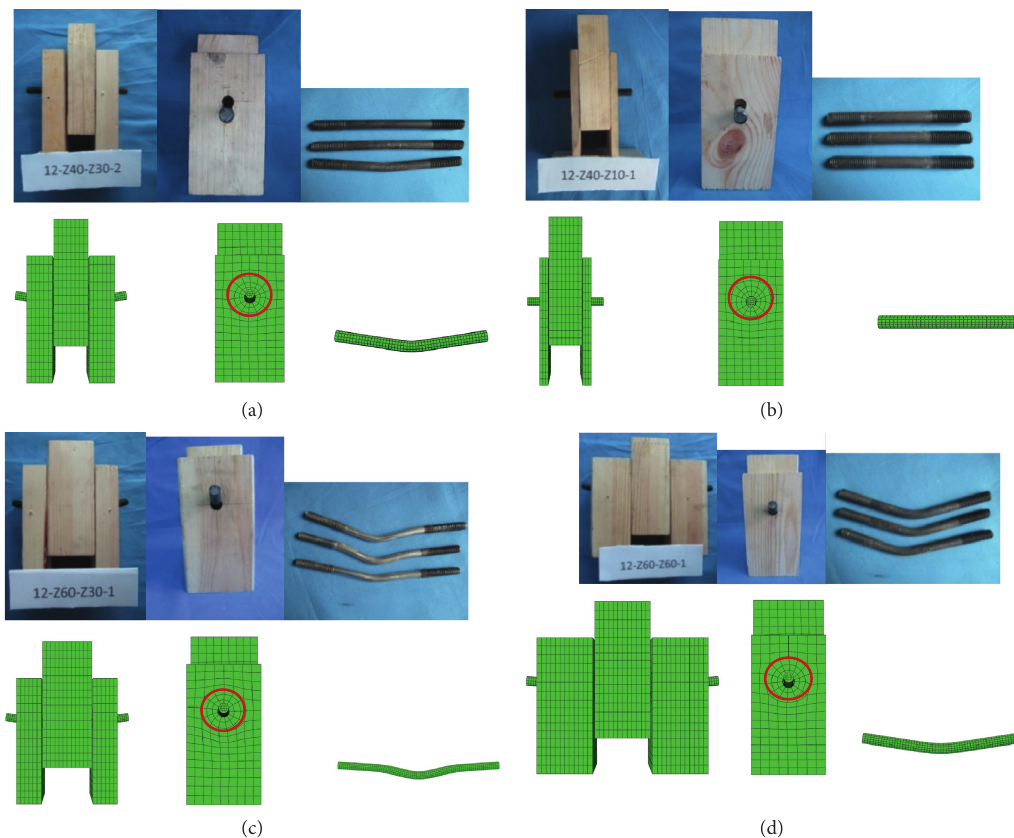
Figure 5: Typical failure models of bolt connection with different thickness combinations both in tests and FE simulations: (a) combination 1: t cm � 40mm and t sm � 30mm; (b) combination 2: t cm � 40mm and t sm � 10mm; (c) combination 3: t cm � 60mm and t sm � 30mm; (d) com- bination 4: t cm � 60mm and t sm � 60mm.